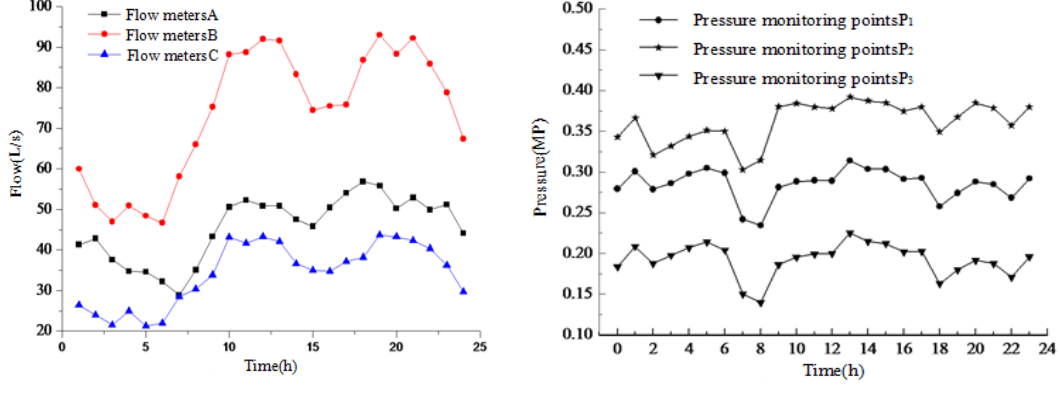
Fig. 7. a. Flow meter measured data, b. Pressure